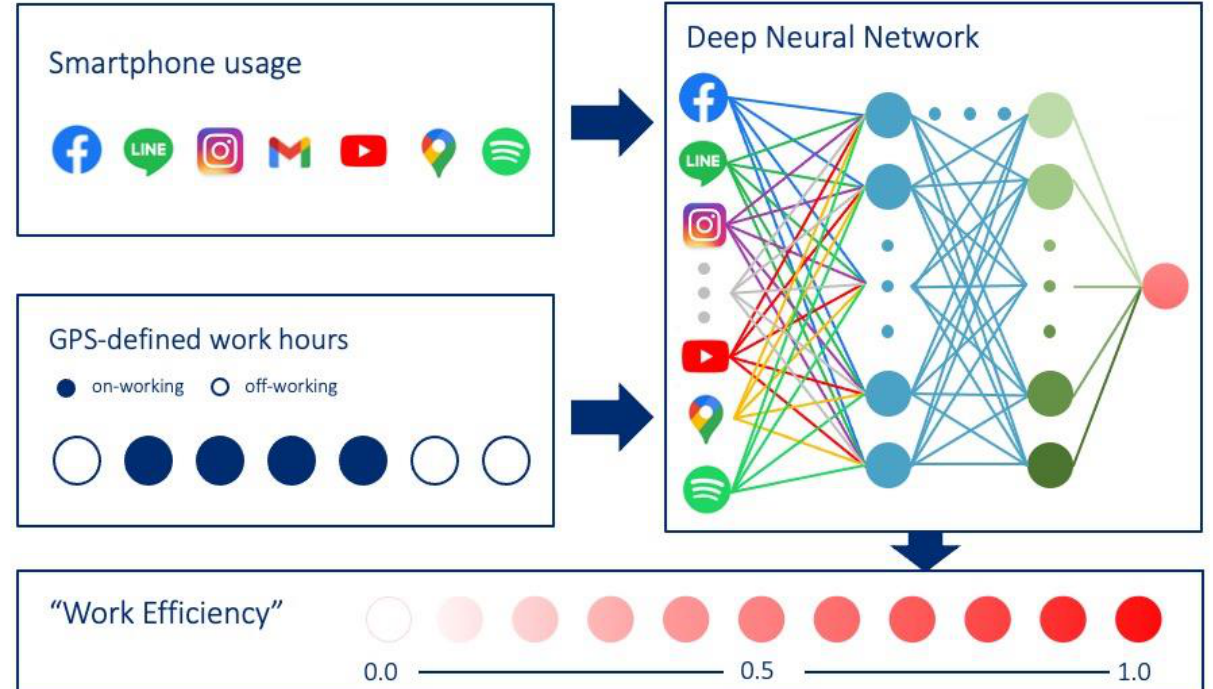
Figure 6. The deep learning model is trained by smartphone usage patterns and the corresponding GPS-defined working status. Smartphone usage patterns are formulated as a time series of screen- on/off, notifications, and types of mobile apps. The GPS-defined working/off-working statuses are labeled as 1 or 0. We will train a multilayer deep neural network and tune the weighing of the model. The trained deep learning model yields a probability between 0 and 1 from any time series of the smartphone usage patterns. This working probability can be interpreted as the work efficiency.